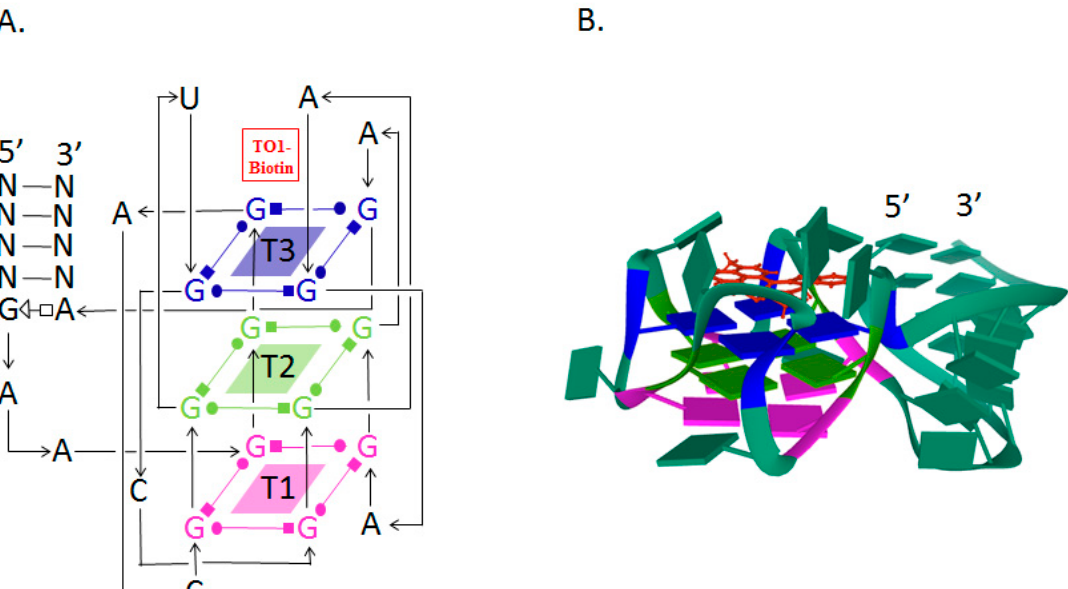
Figure 1. The secondary and tertiary structures of Mango RNA aptamer. ( A ) The secondary structure of Mango RNA aptamer showing the three G-quadruplex regions stacked in three tiers (T1, T2, and T3), where T3 serves as the binding site for TO1-biotin fluorophore [82,83]. ( B ) A cartoon representation of the tertiary structure of Mango RNA aptamer (PDB ID: 6C63) [84].